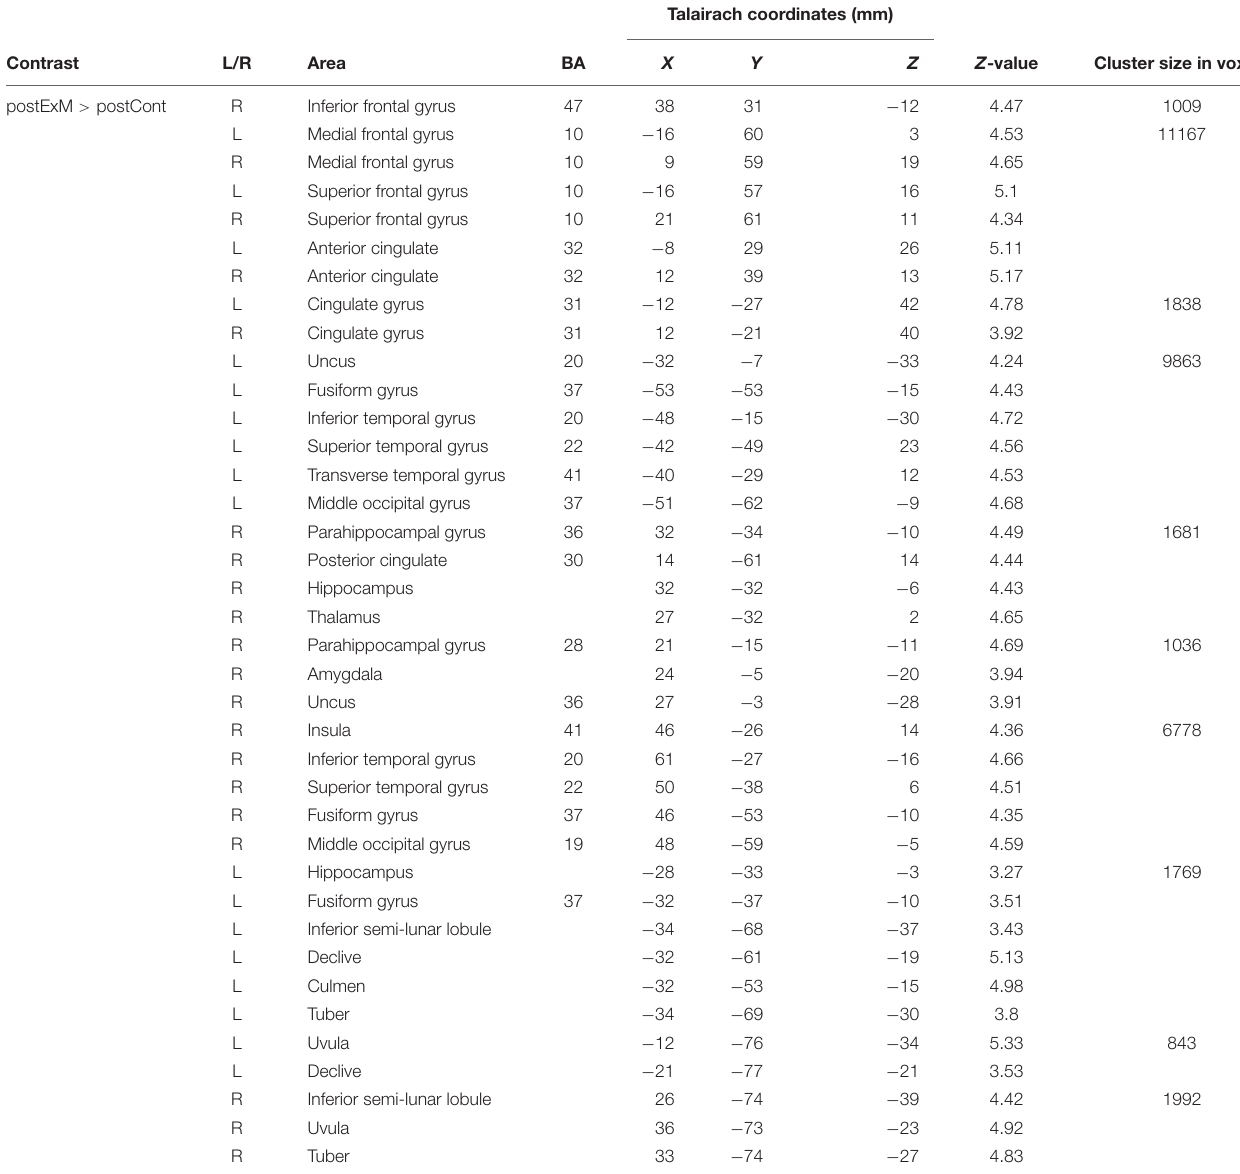
TABLE 3A | Cluster sizes, peak locations, and statistical values for regions showing significant post-intervention large in the ExM group compared to the Cont group.